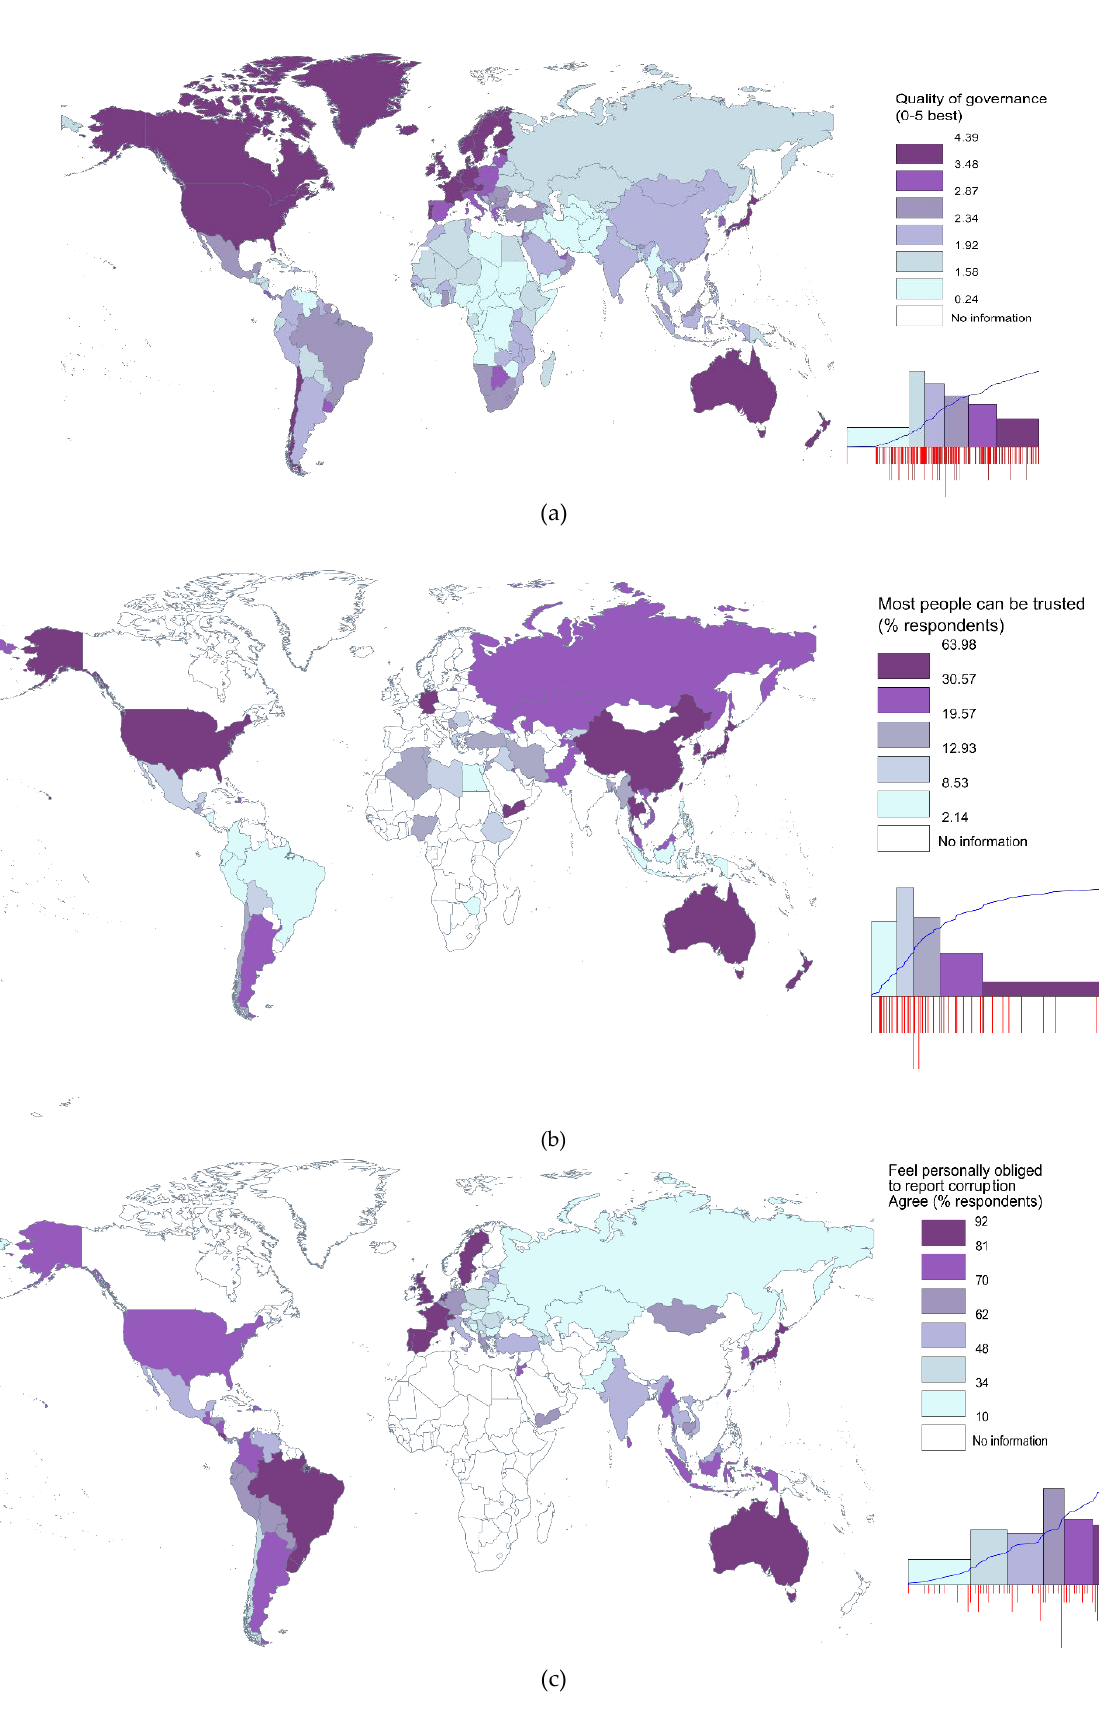
Figure A2. The quality of formal and informal institutions. ( a ) The quality of governance index (0 – 5 best, 2009 – 2013). Notes : The index was rescaled to 0 – 5 values. The six dimensions of the index were aggregated using a factorial analysis. The classes include an equal number of observations. Source : Authors’ representation using data from Transparency Interna- tional and World Value Survey. ( b ) Social trust (% respondents). Notes : Share of people responding that ‘Most people can be trusted’ to the following question: ‘Generally speaking, would you say that most people can be trusted or that you need to be very careful in dealing with people?’ The values are from and around 2017, with a ± 3 years margin interval. The classes include an equal number of observations. Source : Authors’ representation using data from the World Values Sur- vey. ( c ) Personal engagement in reporting corruption (% respondents, 2009 – 2013). Notes : Share of people agreeing with the fol- lowing statement: ‘Feel personally obliged to report corruption’. The values are from and around 2017, with a ± 3 years margin interval. The classes include an equal number of observations. Source : Authors’ representation using data from Transparency International. References 1.